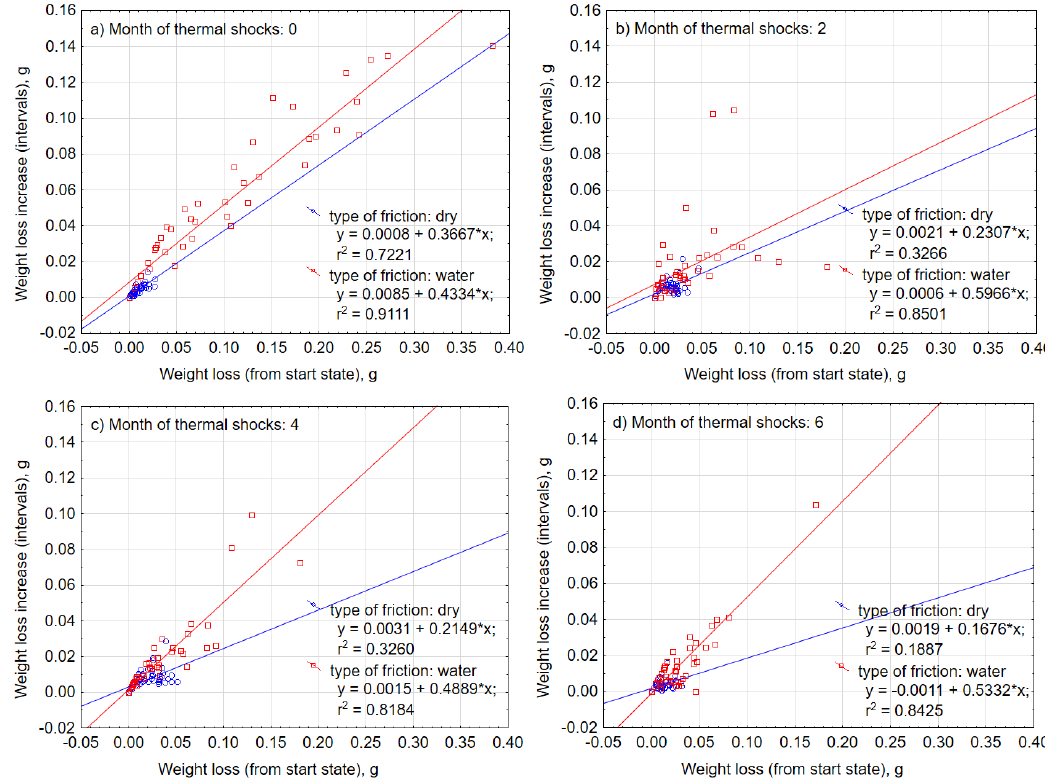
Figure 14. Scattering of the measurements of weight loss after the impact of ( a ) 0, ( b ) 2, ( c ) 4, and ( d ) 6 months of thermal